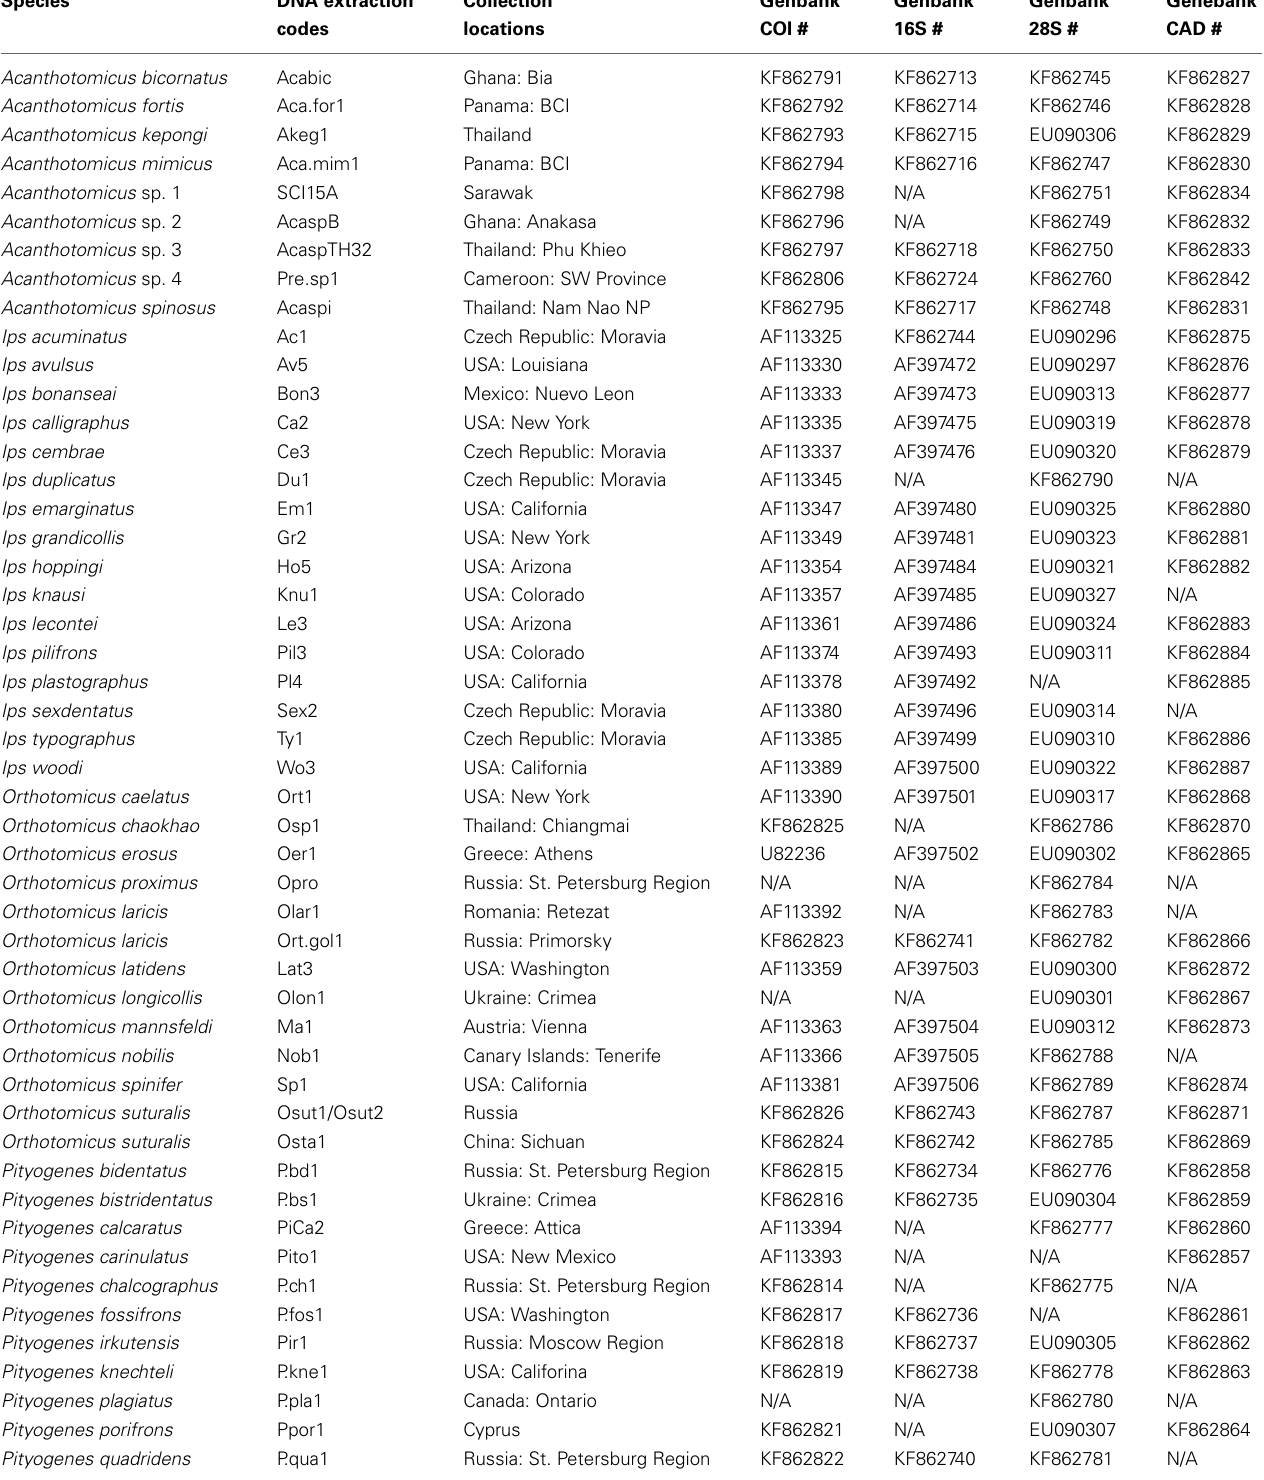
Table 1 | Specimens included in current analyses with associated geographic localities and Genbank accession